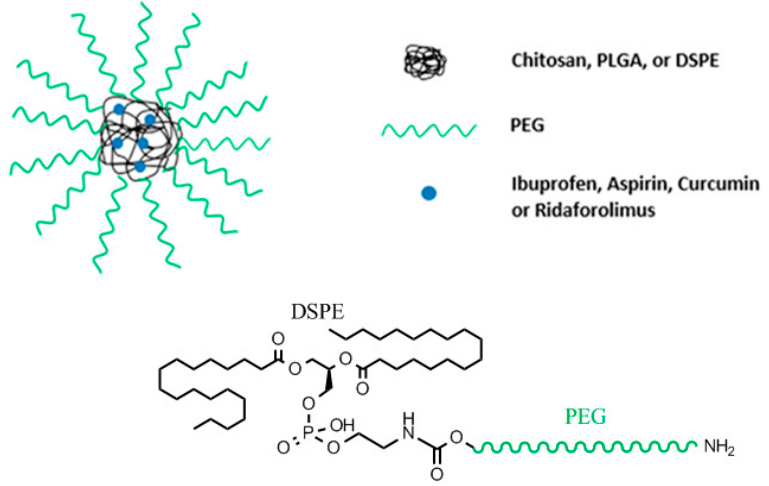
Figure 12. Nanoparticle design of those presented in Sections 4.1–4.3, and chemical connectivity of Ridaforolimus / NH 2 -PEG-DSPE nanoparticle